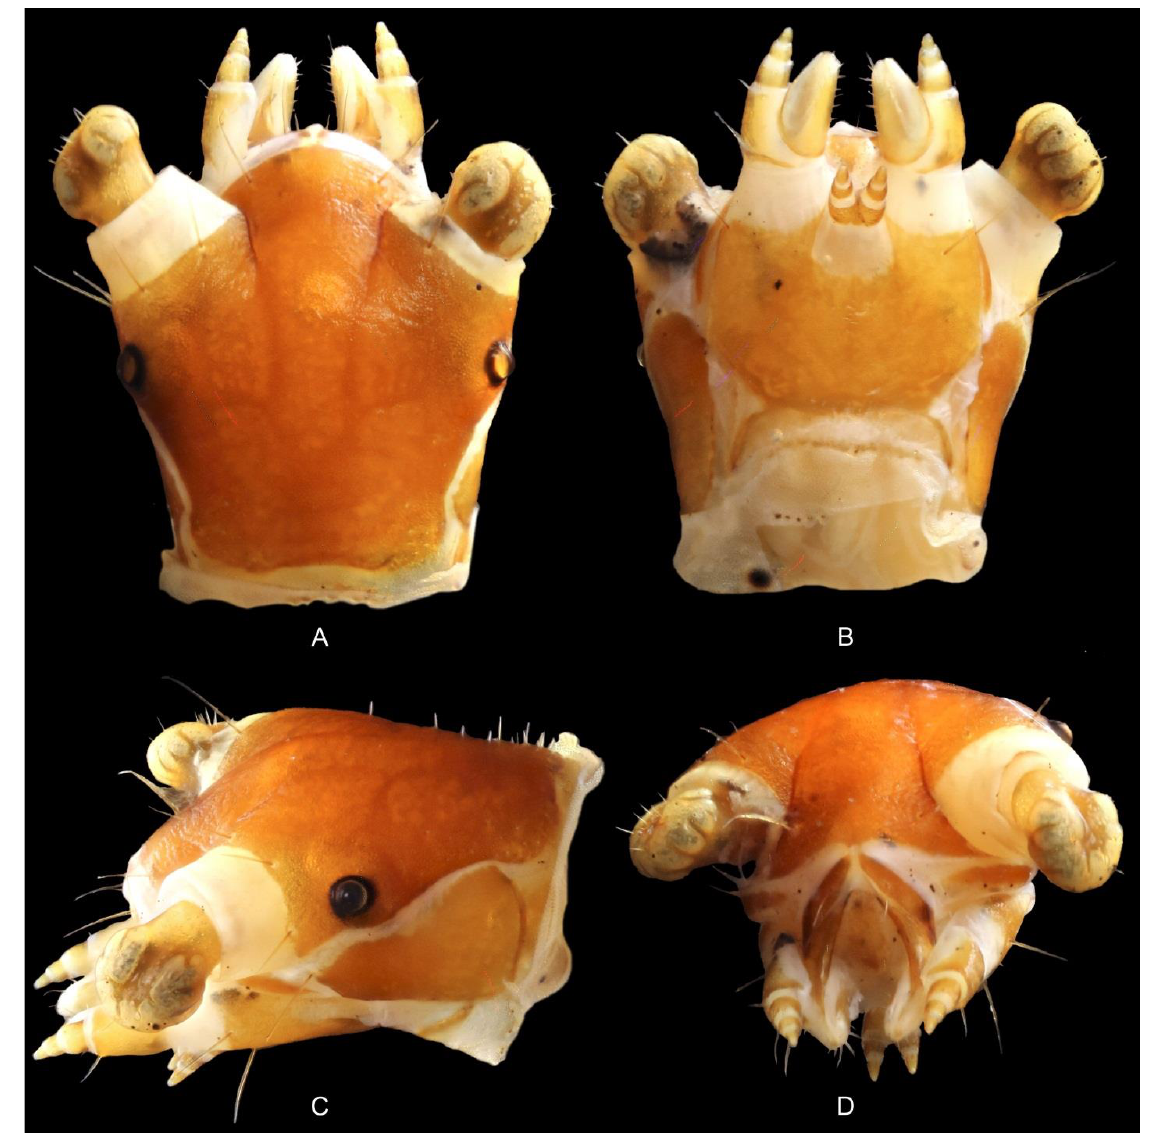
Figure 3. Platerodrilus svetae , female larva. ( A ) — head, dorsally; ( B ) — same, ventrally; ( C ) — same, laterally; ( D ) — same, frontally.